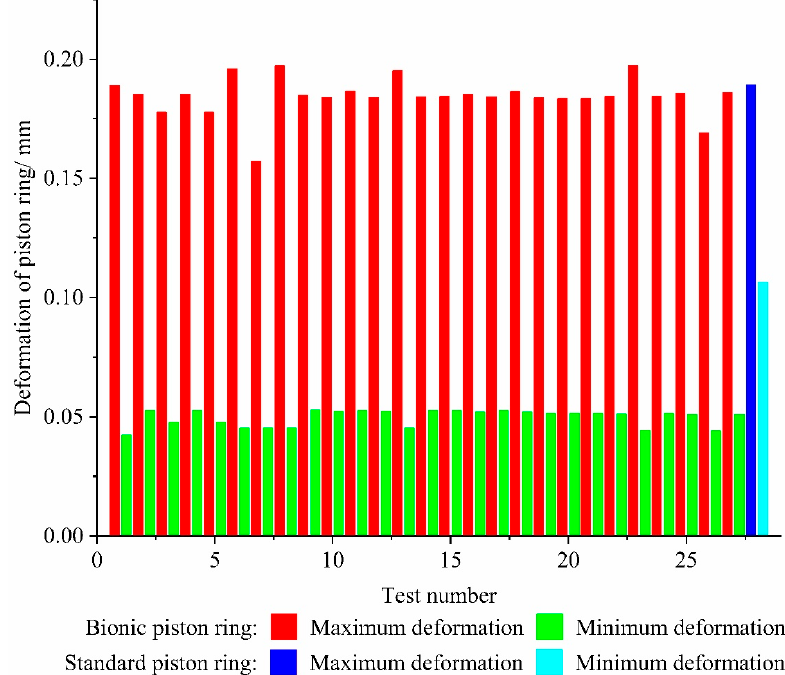
Figure 6. Maximum and minimum deformation of the piston ring group.